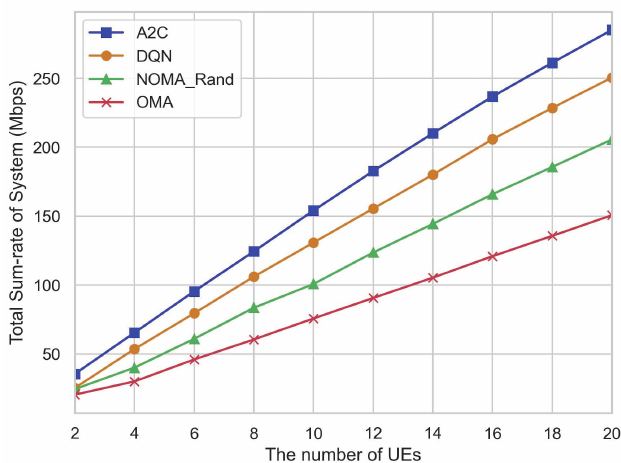
Figure 8. Algorithm performance for different number of users.